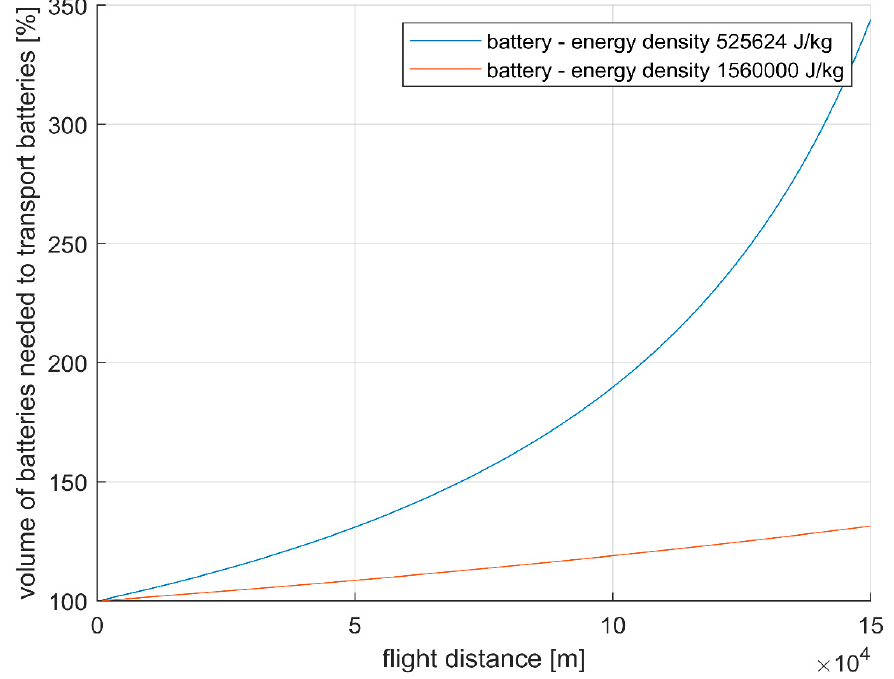
Figure 6. Additional battery mass.